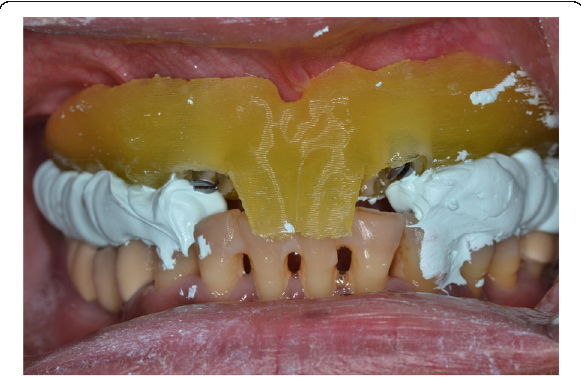
Fig. 8 Intraoral maxillary scan